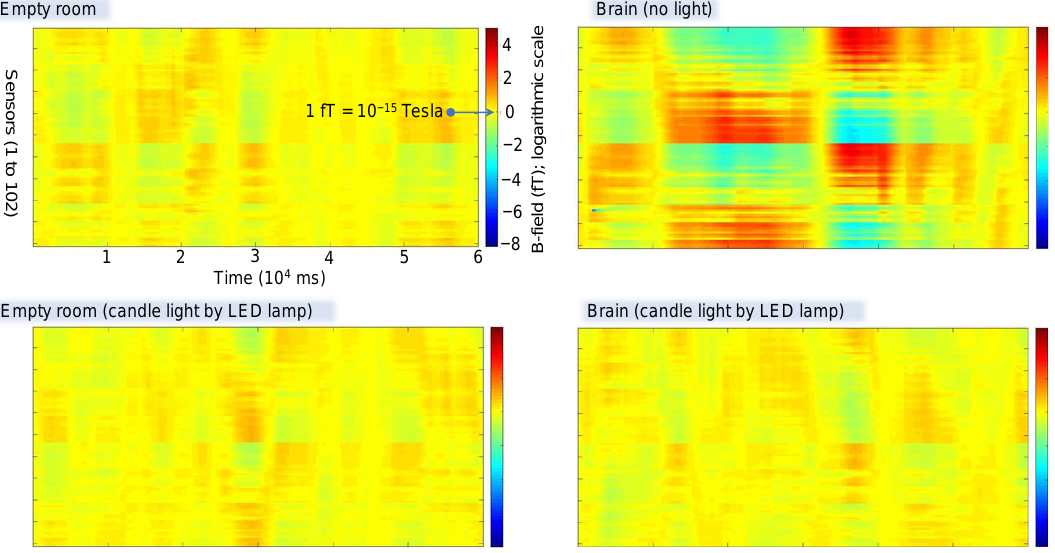
Figure 3. Raw experimental data. Magneto-encephalography (MEG) setup test with and without LED- lamp and person in the MEG scanner; LED-lamp is set for the candle light 1500 K color temperature. Scanner No. 29 is excluded from the plot due to erroneous data. Data color-maps are plotted on the same intensity